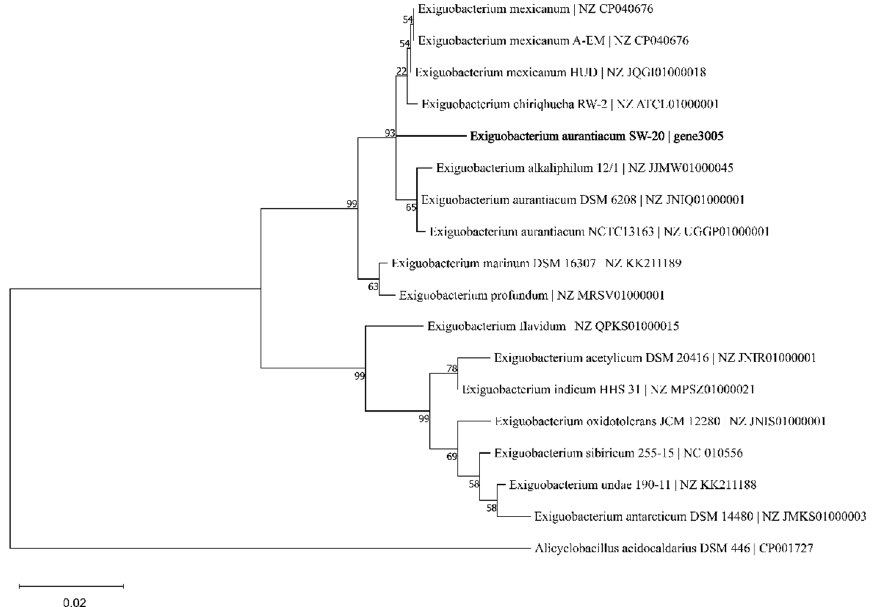
Figure 1. Phylogenetic tree of E. aurantiacum SW-20 and its closest related species based on 16S rRNA gene sequence similarity using Maximum-Likelihood algorithm ( Jukes-Cantor model). The outgroup used was Alicyclobaciillus acidocaldarius DSM 446. Bootstrap value represents 2000 replicates and random seeding. Tree was built using Mega v.11.